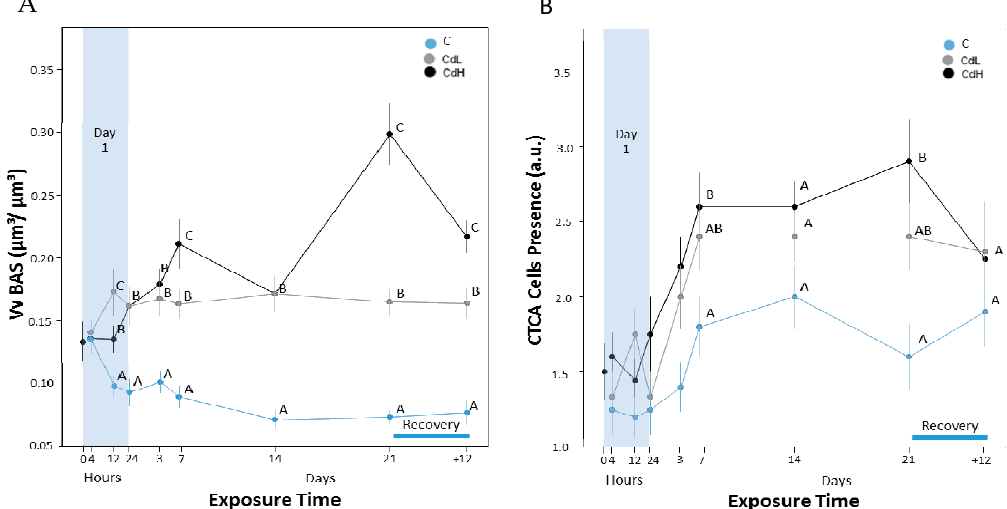
Figure 7. ( A ) Time course of volume density of basophilic cells (V VBAS ) in the midgut gland tubules of Littorina littorea . Means (symbols) and standard errors (bars) are shown. Different letter codes between single values of the same time point indicate statistically significant differences ( p < 0.05). ( B ) Progression of the presence of connective tissue calcium cells (CTCA) in the midgut gland of periwinkles, expressed in arbitrary units (a.u.) (see Table 1 in the Materials and Methods section for explanation). Means (symbols) and standard errors (bars) are shown. Different letter codes between single values of the same time point indicate statistically significant differences ( p < 0.05).